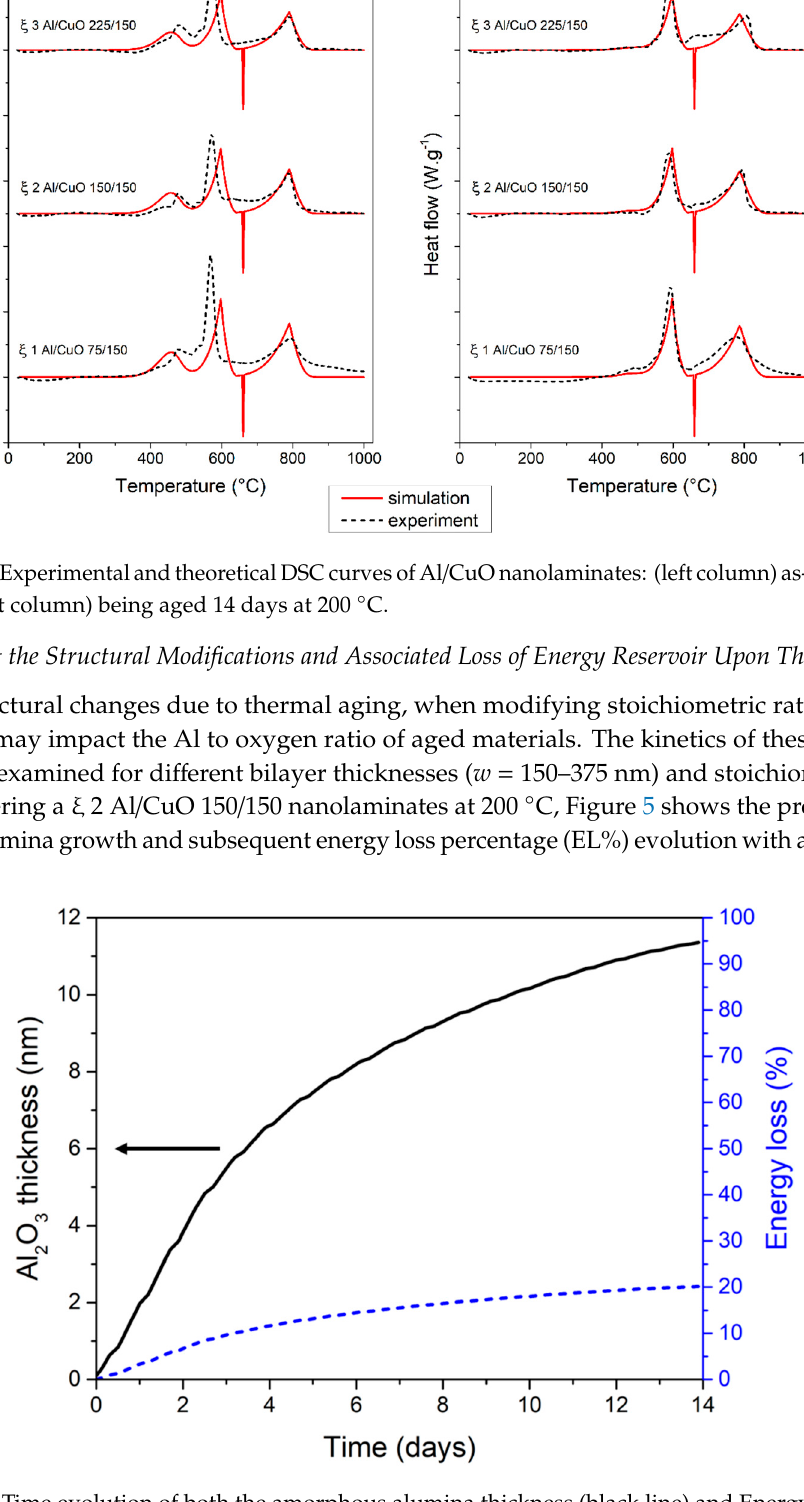
Figure 5. Time evolution of both the amorphous alumina thickness (black line) and Energy loss EL% (dashed blue line), for a ξ 2 Al/CuO 150/150 nanolaminate, aged 14 days at 200 °C.